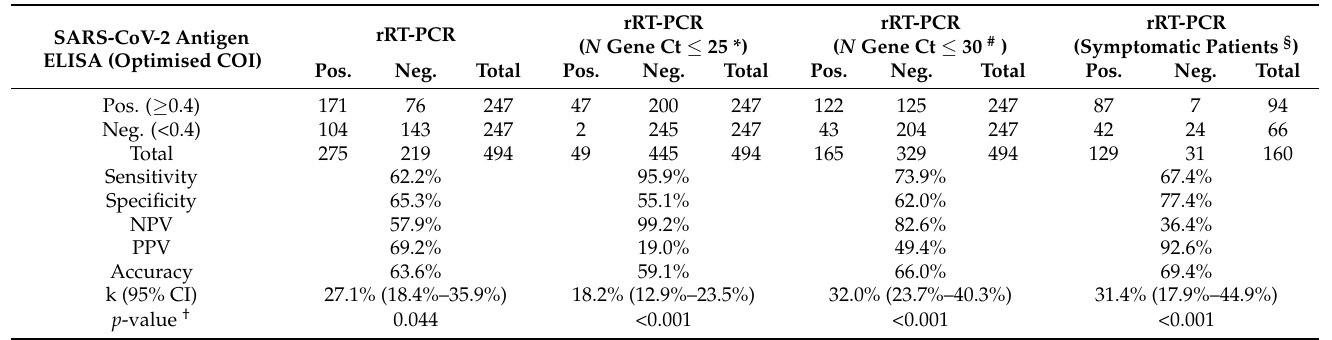
Table 8. Results of reference method (rRT-PCR) and tested method (SARS-CoV-2 Antigen ELISA) using an optimised cut-off